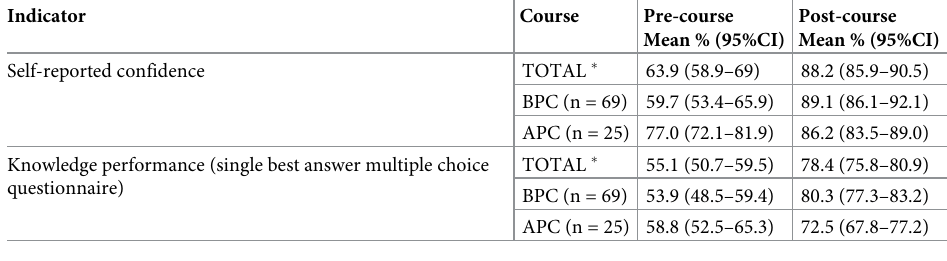
Table 1. Pre- and post-course self-reported confidence and knowledge performance by course.